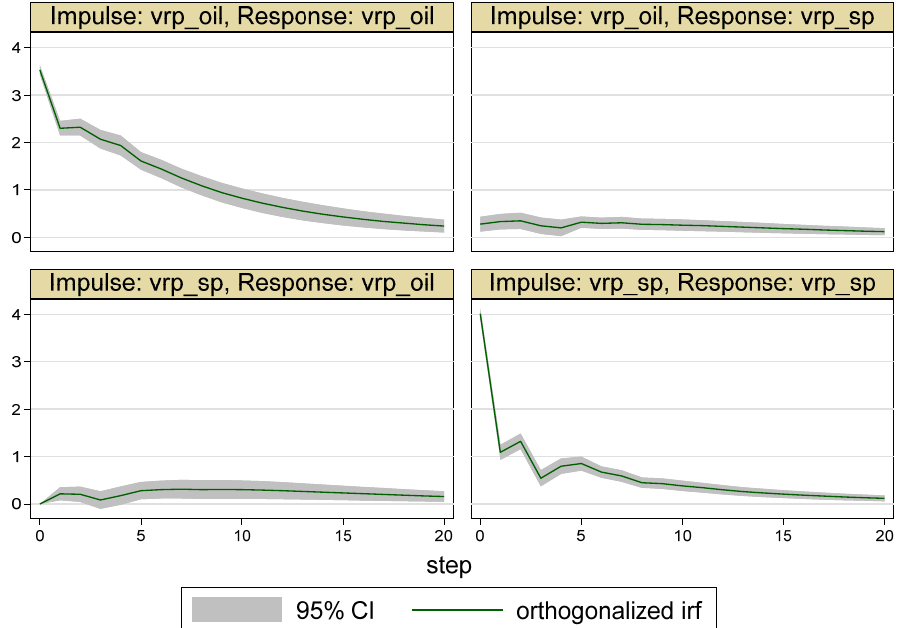
Figure 3. Impulse response functions (whole period). Notes: Vrp_oil (resp. vrp_sp) represents volatility risk premium of oil (resp. stock). The solid line represents orthogonalized impulse response functions and the gray area represents their 95% confidence intervals. The above-right graph shows the impulse response functions of vrp_sp to vrp_oil. The below-left graph shows the impulse response functions of vrp_oil to vrp_sp. Table 6. Variance decompositions (whole